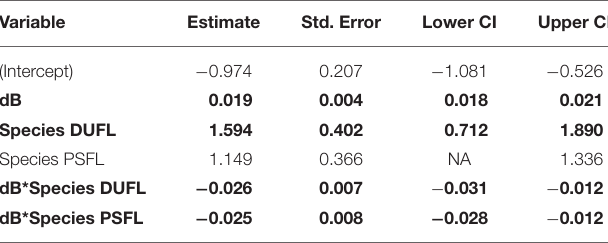
TABLE 5 | The output for a linear mixed effect model of the flycatching guild.